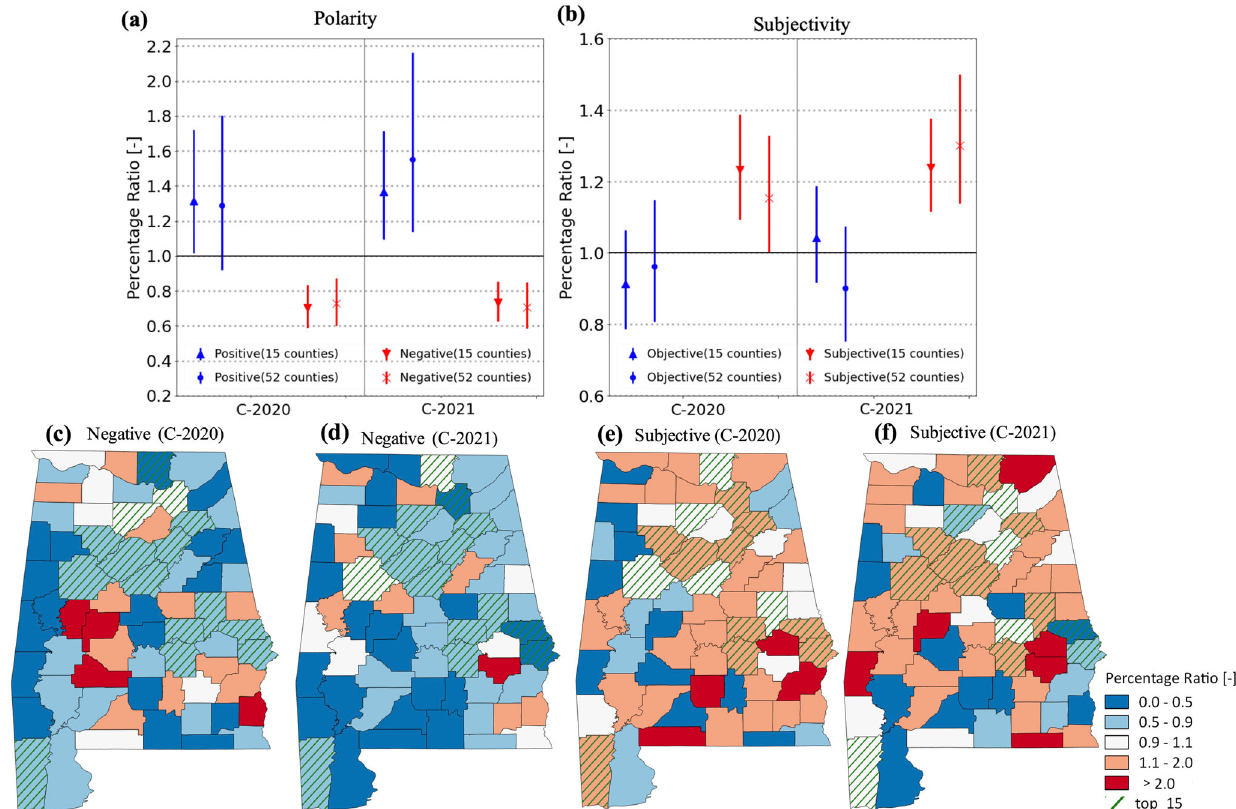
Fig. 4 Altered sentiment of water pollution complaints during the COVID-19 pandemic. Triangles and downward triangles (circles and cross markers) in ( a ) depict the percentage ratios of positive and negative complaints, respectively, based on polarity scores to the state-level percentages for the top 15 counties (other 52 counties) during 2020-21. Triangle and downward triangles (circles and cross markers) in ( b ) depict the percentage ratios of objective and subjective complaints, respectively, based on subjectivity scores to the state-level percentages for the top 15 (other 52) counties during 2020-21. Error bars depict the 95th percentile ranges of the percentage ratios complaints from 10,000 bootstrapped samples. County-level maps in ( c , d ) and ( e , f ) depict of ratios of the percentage ratios of negative (subjective) complaints during